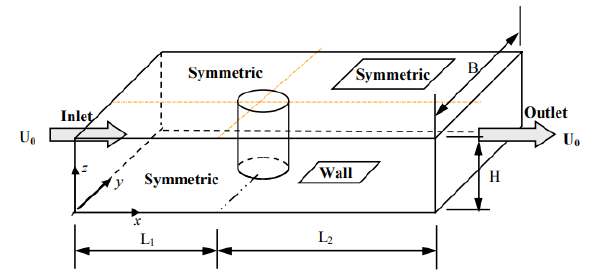
Fig. 4. Geometry of the SPH simulation